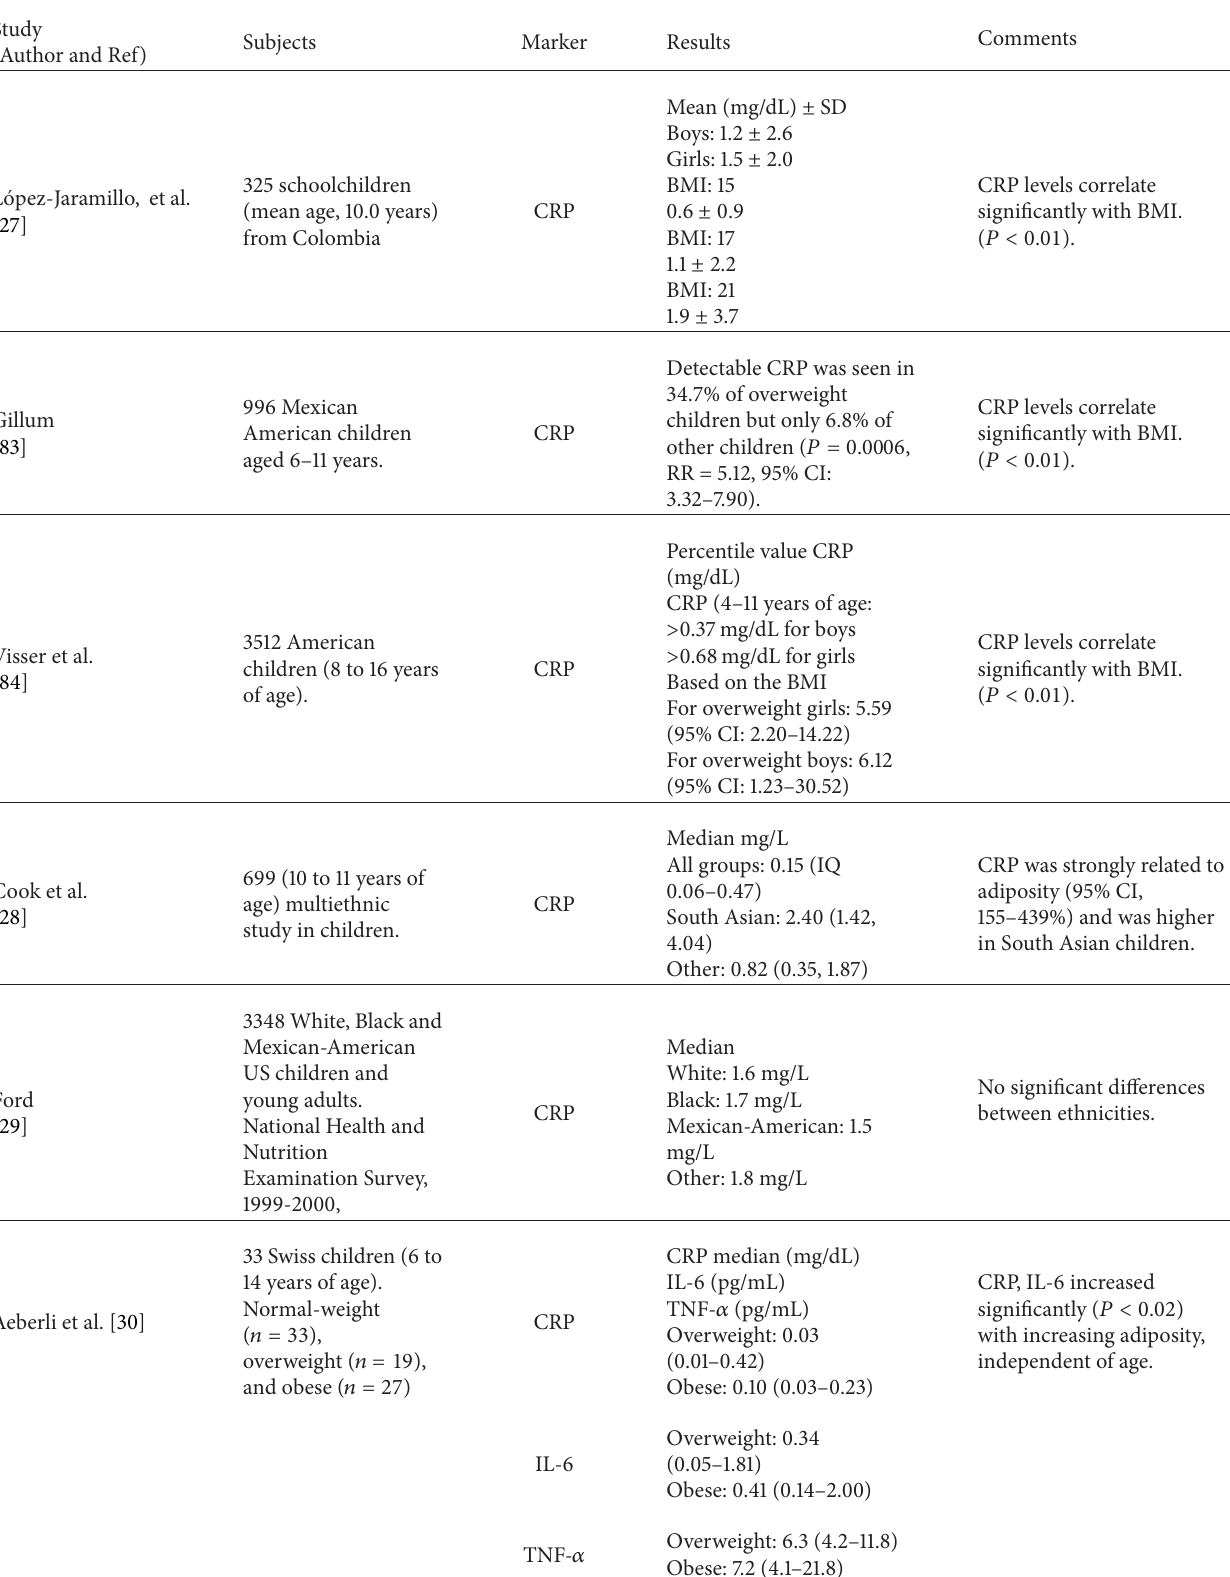
Table 3: Pro-inflammatory cytokines in children and